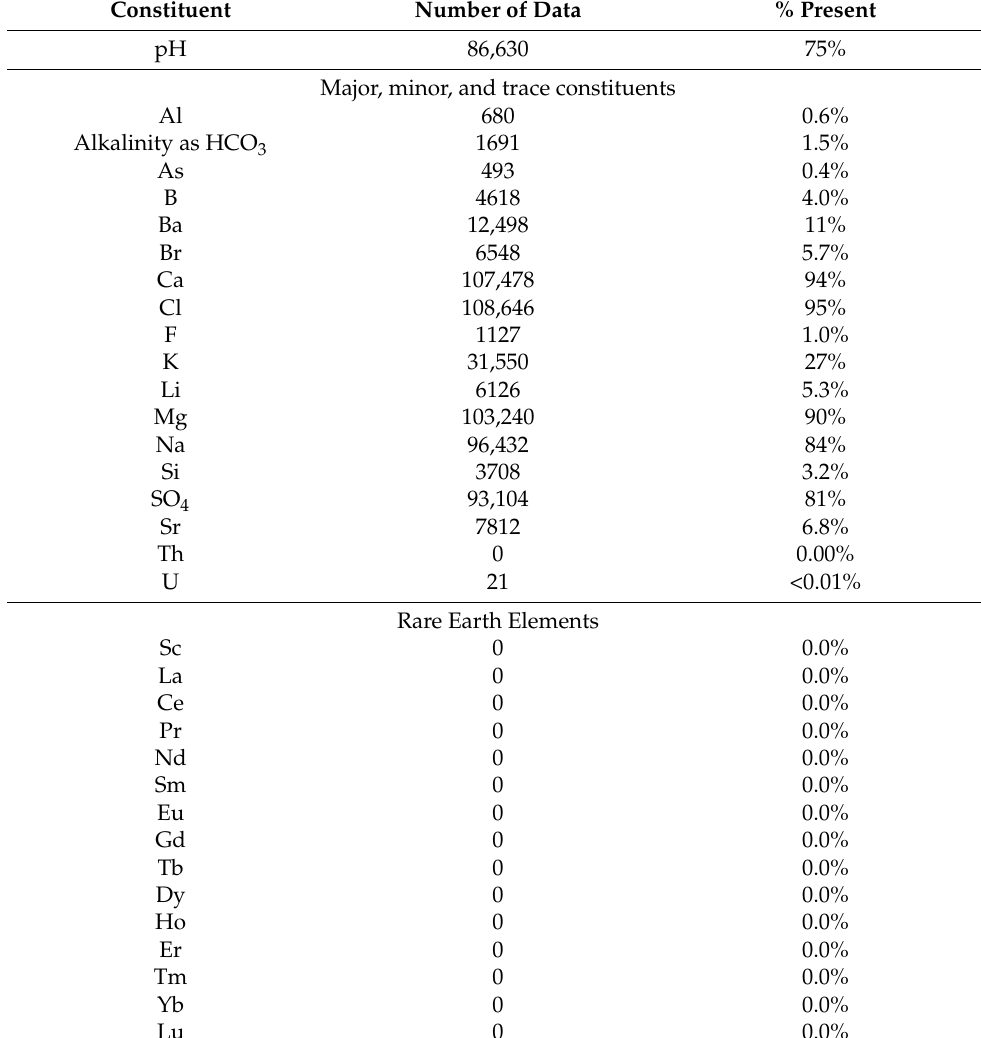
Table 4. Number of concentration data present from the USGS Produced Waters Geochemical Database (Version